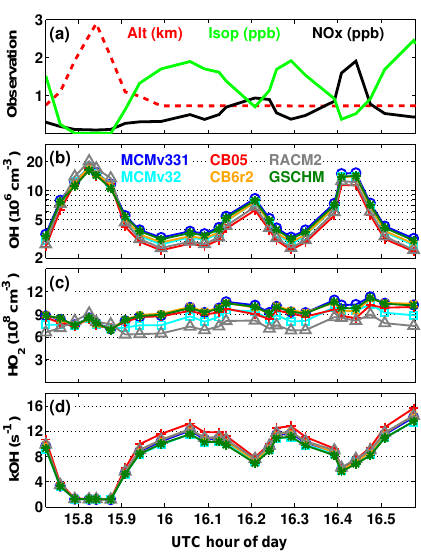
Figure 6. (a) Time series of pressure altitude (red dashed line) and observed mixing ratios of isoprene (green line) and NO x (black line) for the SENEX Atlanta area flight leg discussed in Sect. 3.4. Observations from this dataset drive steady-state simu- lations for comparison of modeled OH (b) , HO 2 (c) , and OH reac- tivity (d) among six chemical mechanisms: MCMv3.3.1 (blue cir- cles), MCMv3.2 (cyan squares), CB05 (red + ), CB6r2 (orange × ), RACM2 (gray triangles), and GEOS-Chem (green asterisks).